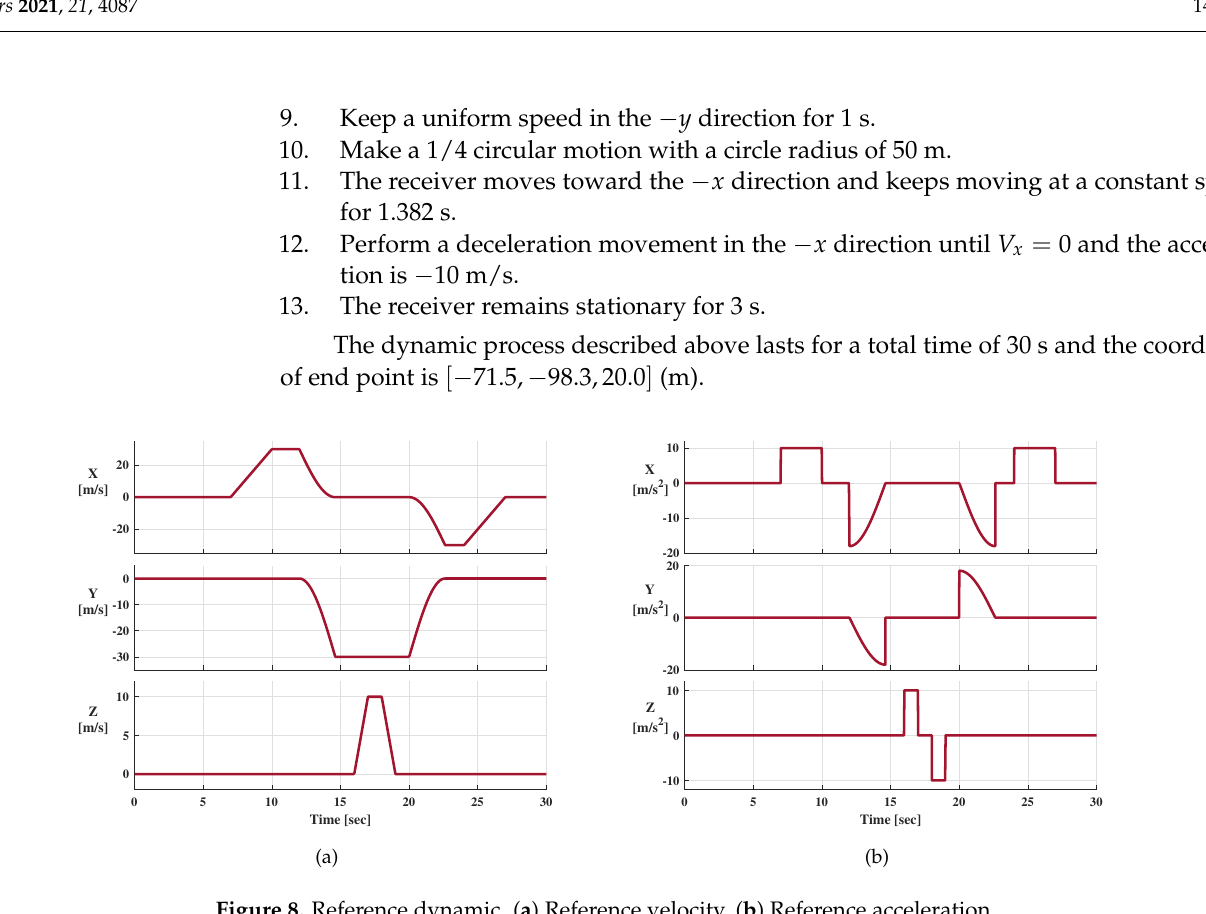
Figure 8. Reference dynamic. ( a ) Reference velocity. ( b ) Reference